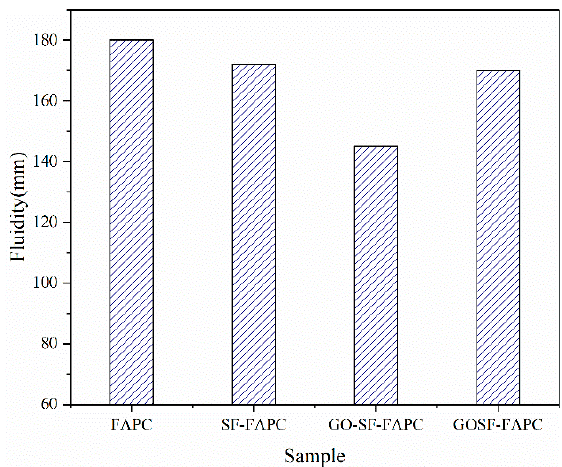
Figure 8. The fluidity of cement paste in experiment 1.